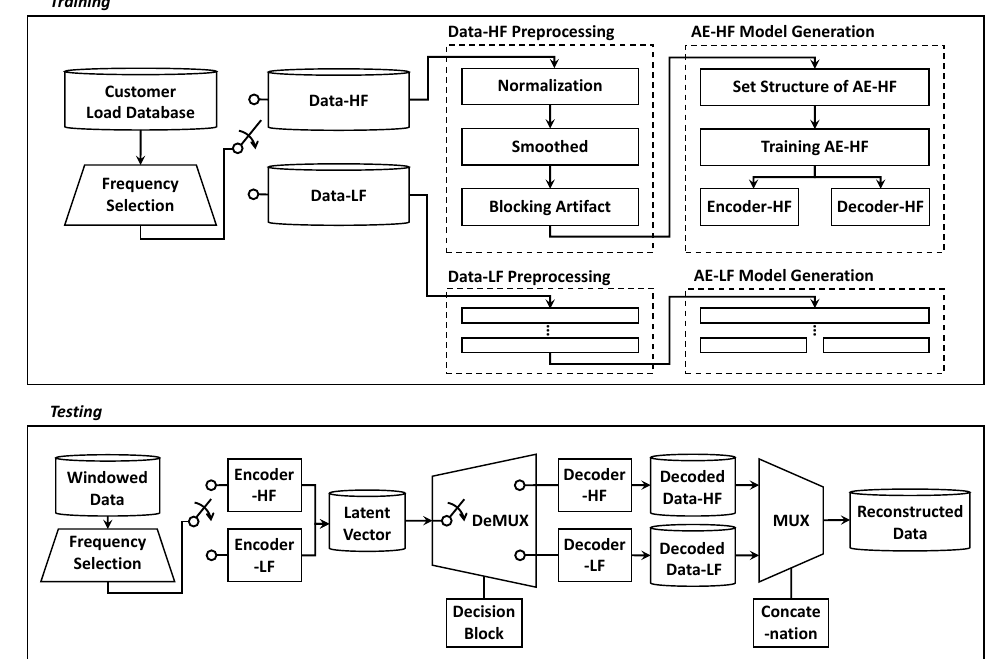
Figure 4. Application to the auto-encoder